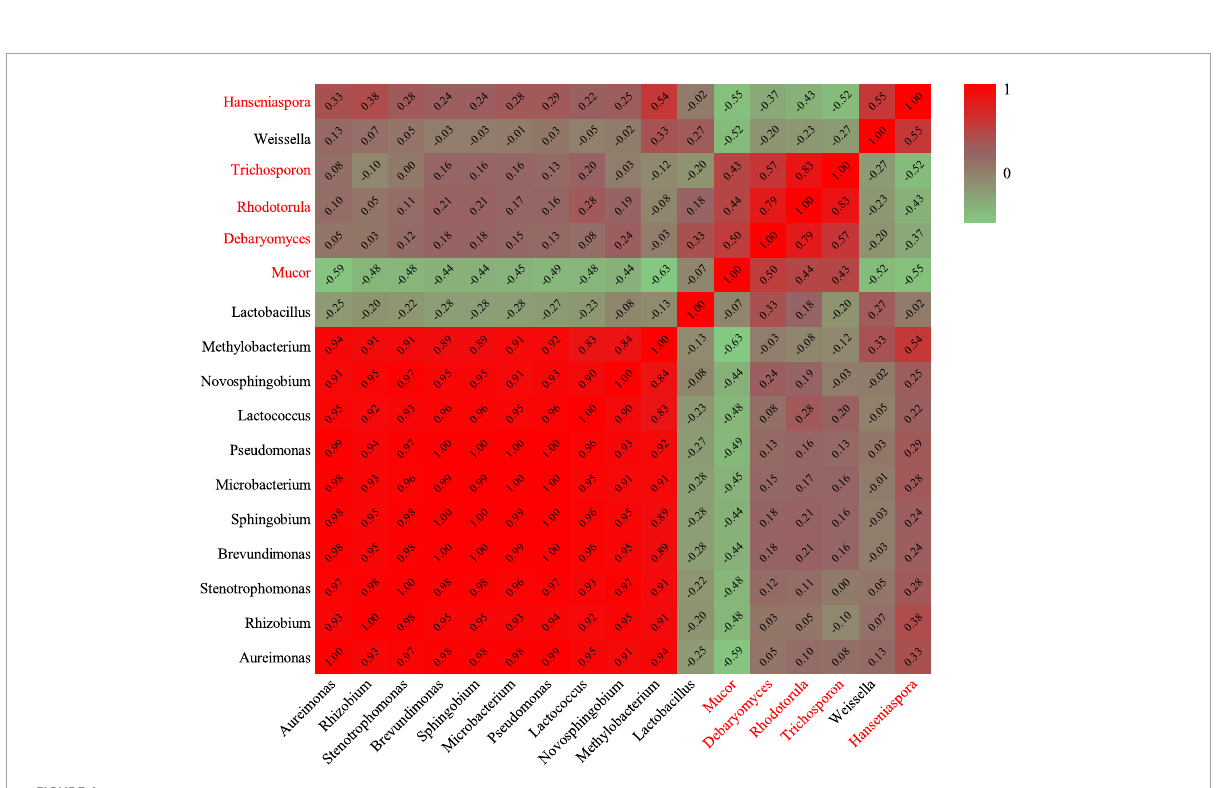
Frontiers in Nutrition